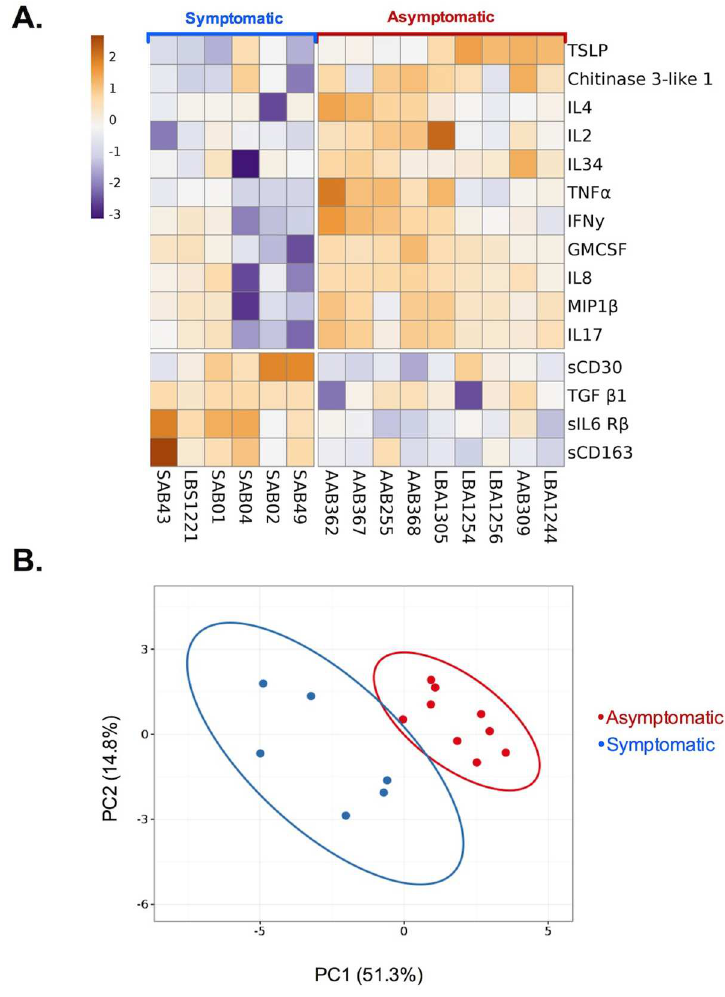
Fig 7. Heat map and principal component analysis of reciprocally expressedcytokines. (A) A heat map was generatingusing log 2 -transformed concentration values of 15 differentiallyexpressed cytokines identified using multiplexanalysisto visualizedifferencesbetweensymptomatic and asymptomatic malaria patient groups. Values were centeredby subtractingthe mean cytokine concentration from all samples from each individual data point. (B) Scatter plot of the first two principal components (comprising 66.1% of total variance) calculatedusing singularvalue decomposition (SVD) with imputation. Symptomatic patient values (blue closed circles) and asymptomatic patient values (red closed circles) cluster separately. Coloredellipses denotecalculated95% confidencelevels of new observations from other patients from this population structure (symptomatic vs. asymptomatic) falling within the respectiveregions. There is minimaloverlap betweenthe confidencelevels betweenpatient populations. Both the heat map and PCA were constructed using ClustVis [39].